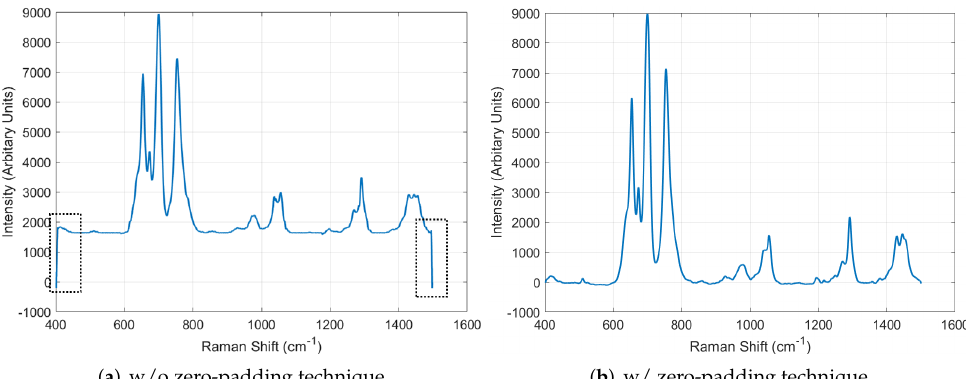
Figure 11. Evaluation of the effect of using the zero-padding